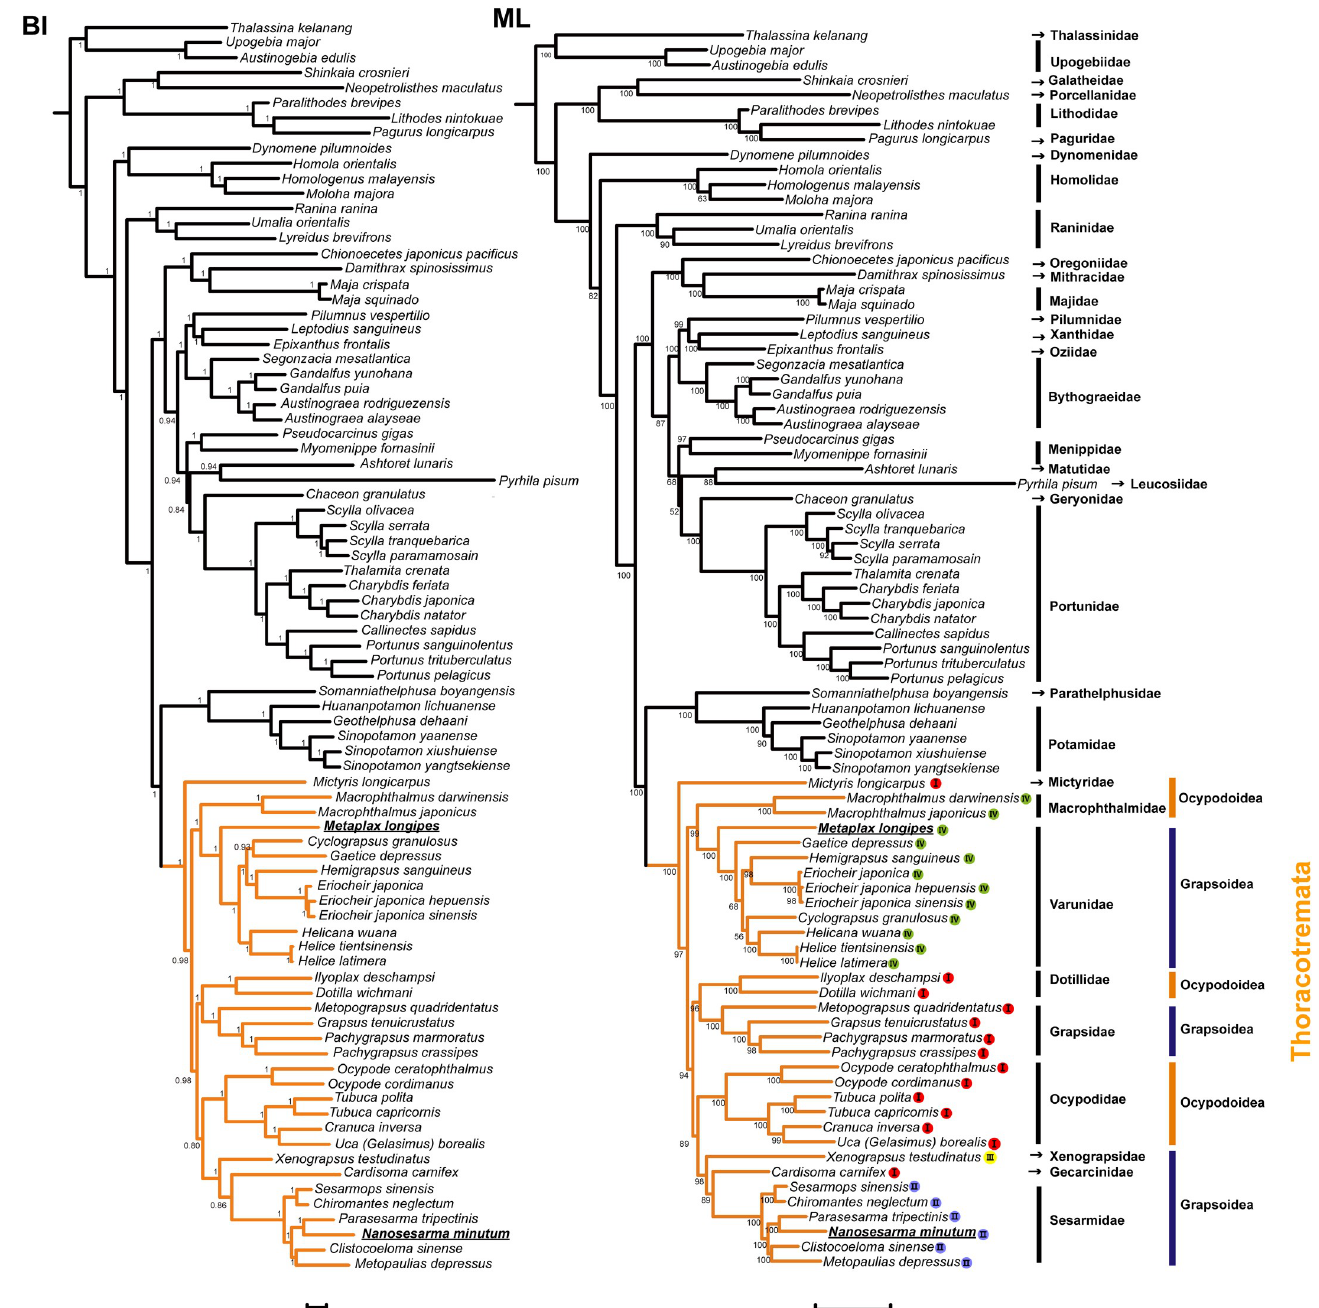
Fig 3. Trees show phylogeny of Brachyura using Bayesian inference (BI) and Maximum likelihood method (ML), based on the 13 protein-coding genes and two rRNAs. Values at the branches represent Bayesian posterior probabilities (BPP)/ ultrafast bootstrap values (BS). Within Thoracotremata, the codes (I–IV) behind tips of the branches correspond to the gene rearrangement patterns listed in Fig 4, and the mitogenomes sequenced in this study are underlined and bold.